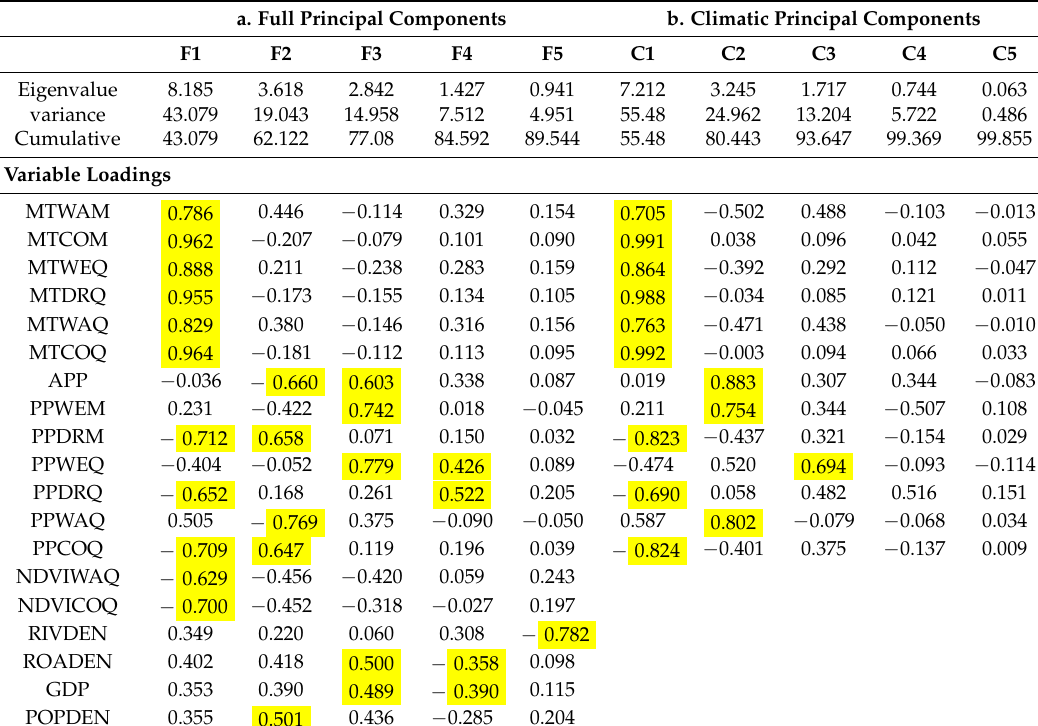
Table 2. Standardized principal components analysis, using ( a ) climatic variables only, and ( b ) climatic, environmental, and socioeconomic variables. Only the first five principal components are shown in both cases. The variables with the highest absolute loading values are